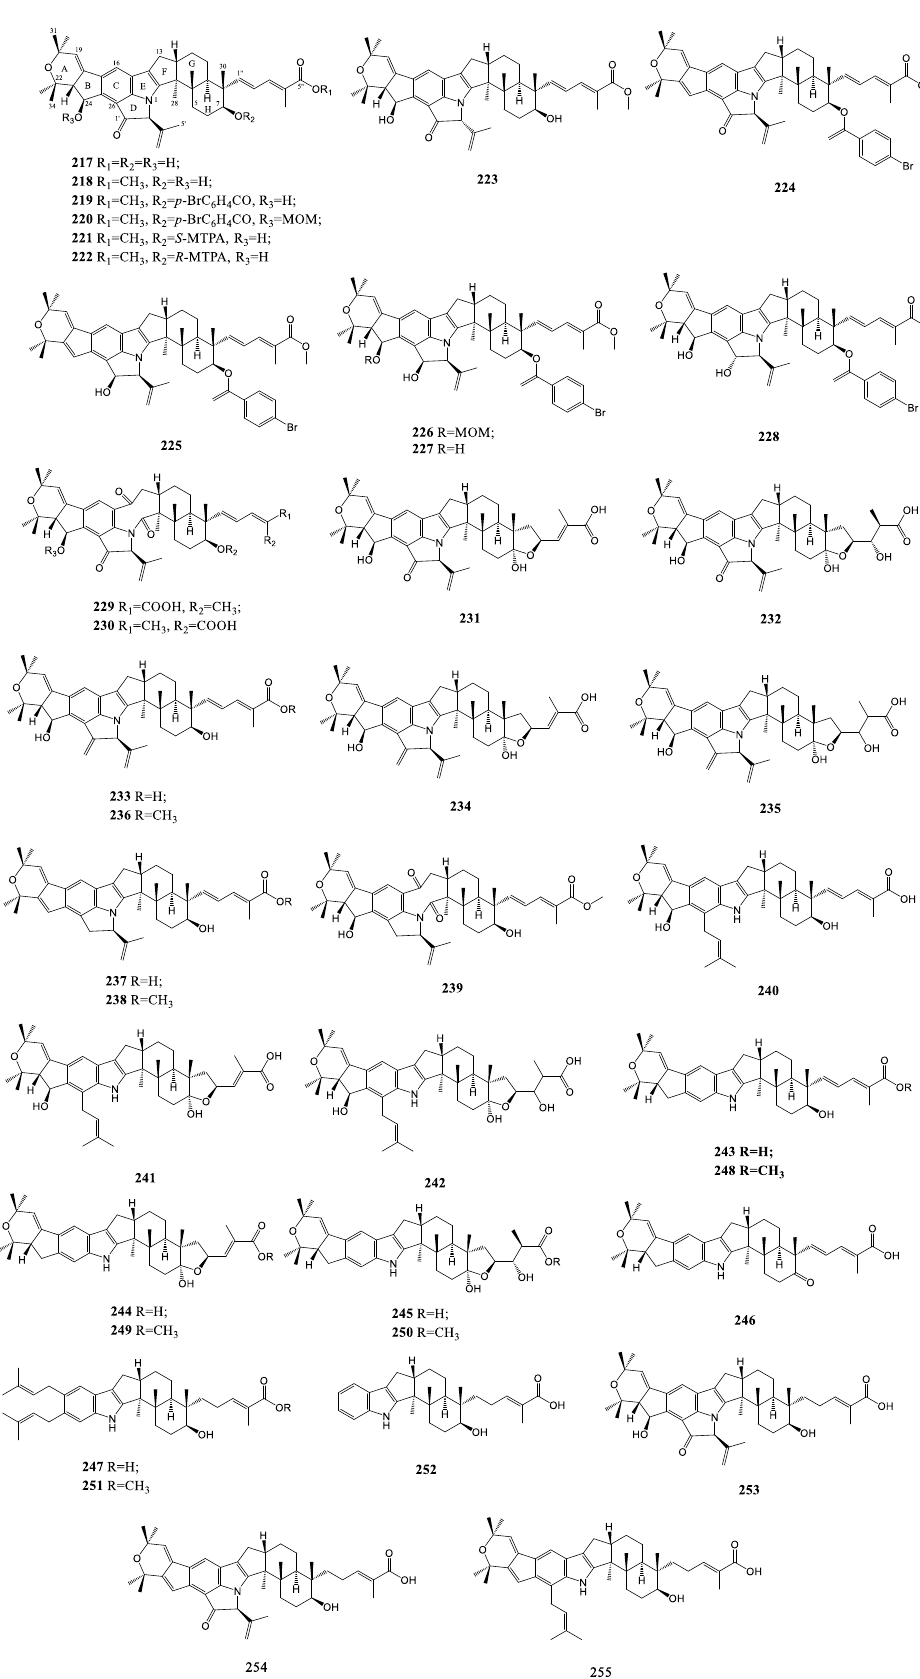
Figure 12. Structures of nodulisporic acid indole diterpenes.